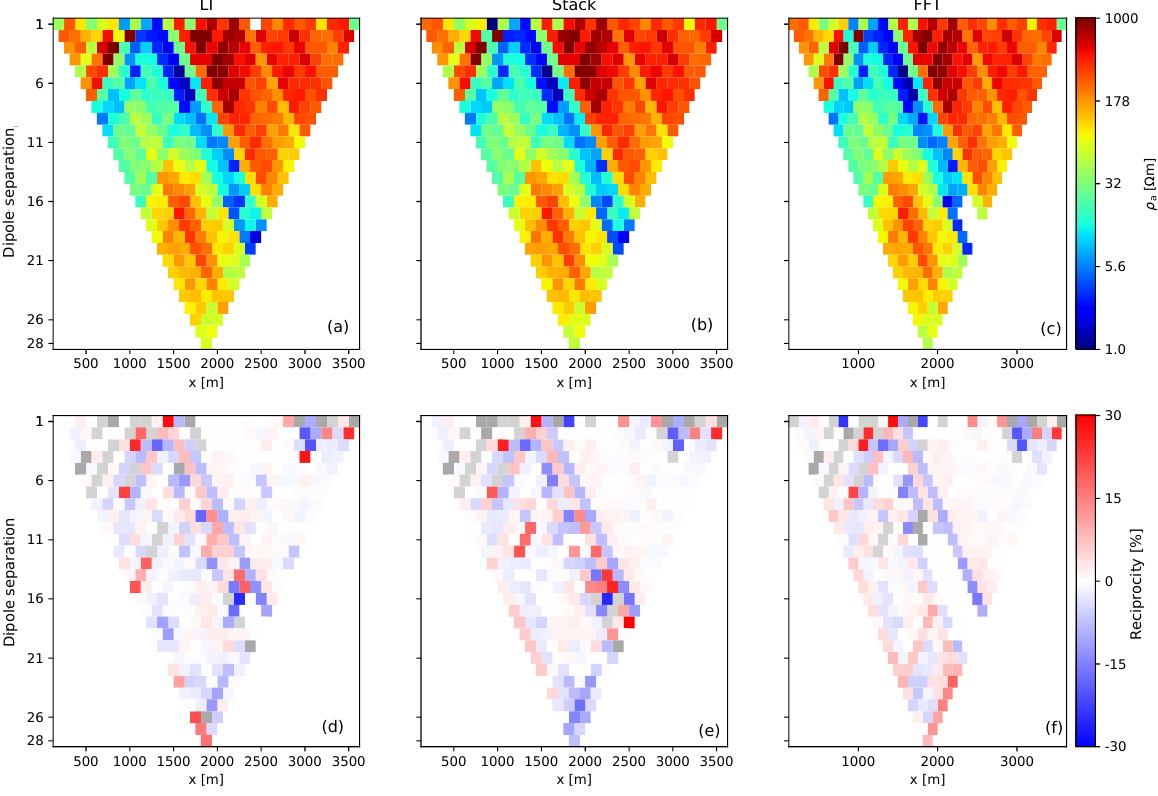
Figure 15. Calculated apparent resistivity (a, b, c) and normal reciprocity (d, e, f) for the three analysis approaches, lock-in (a, d) , stacking (b, e) and FFT (c, f)